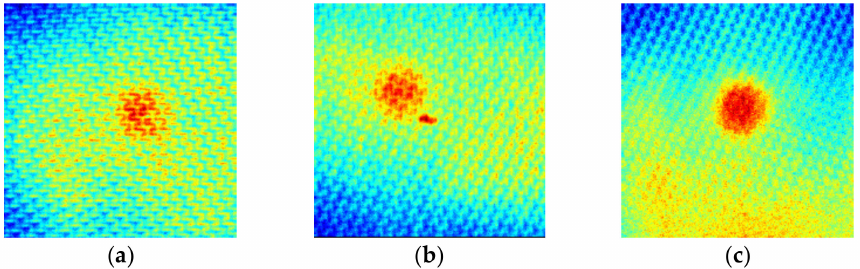
Figure 16. Thermographic images of the ( a ) front face and ( b ) back face of panel 1 and ( c ) the front face of panel 3.